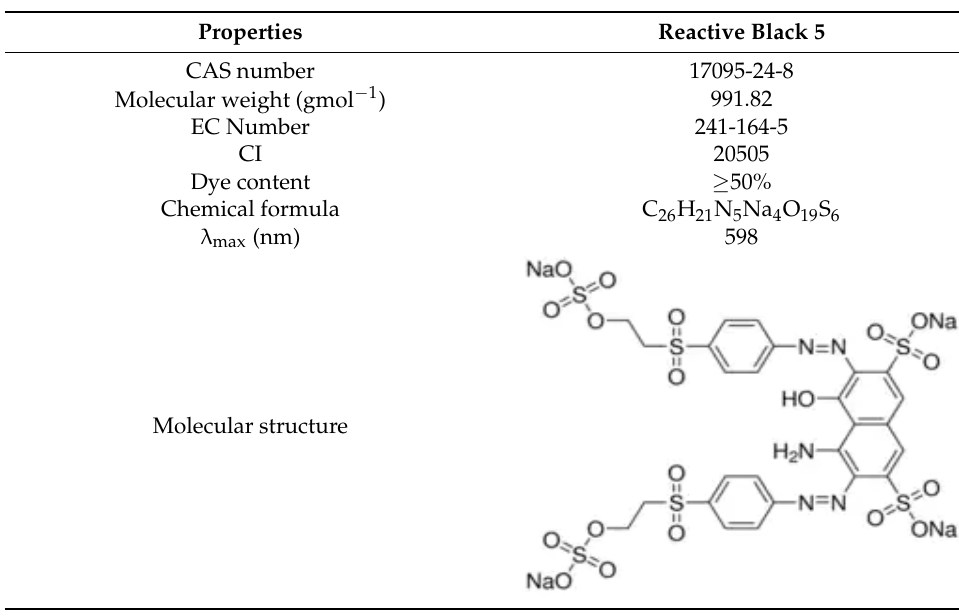
Table 1. Properties of Reactive Black 5 dye.